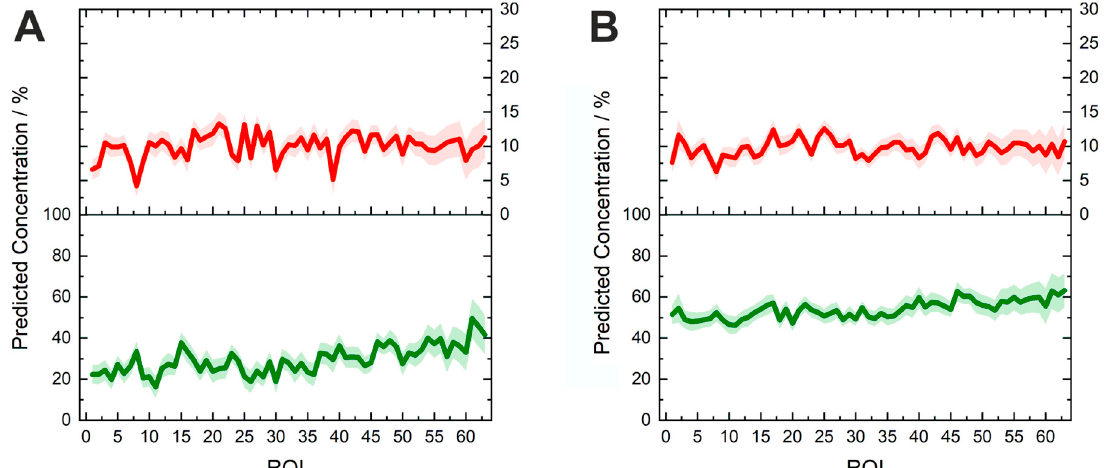
Figure 5. Predicted concentrations of lumefantrine (green, lower line) and artemether (red, upper line) in di ff erent spots on the model tablets. Each region of interest (ROI) indicates the imaged area from a single fiber in the fiber array. ( A ) Lu50Ar100: 50% of the nominal lumefantrine and 100% of the nominal artemether content, corresponding to 30 wt% lumefantrine and 10 wt% artemether in the tablet. ( B ) Lu100Ar100: 100% the nominal content of lumefantrine and artemether, corresponding to 60 wt% lumefantrine and 10 wt% artemether in the tablet).